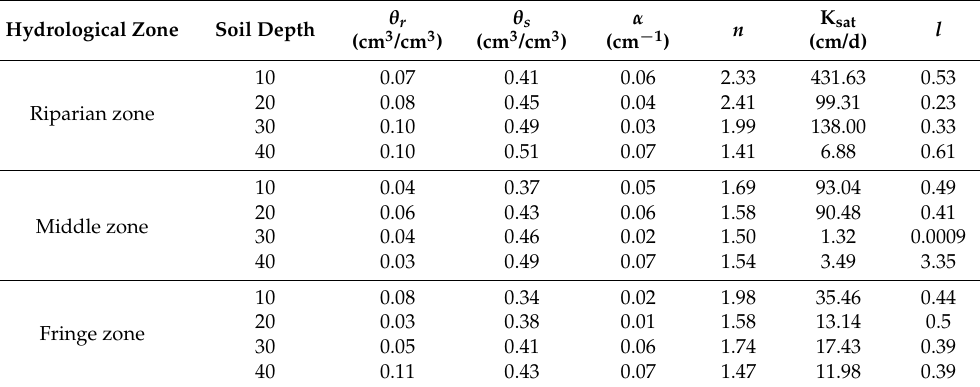
Table 8. Averaged calibrated hydraulic parameters at each hydrological zone.